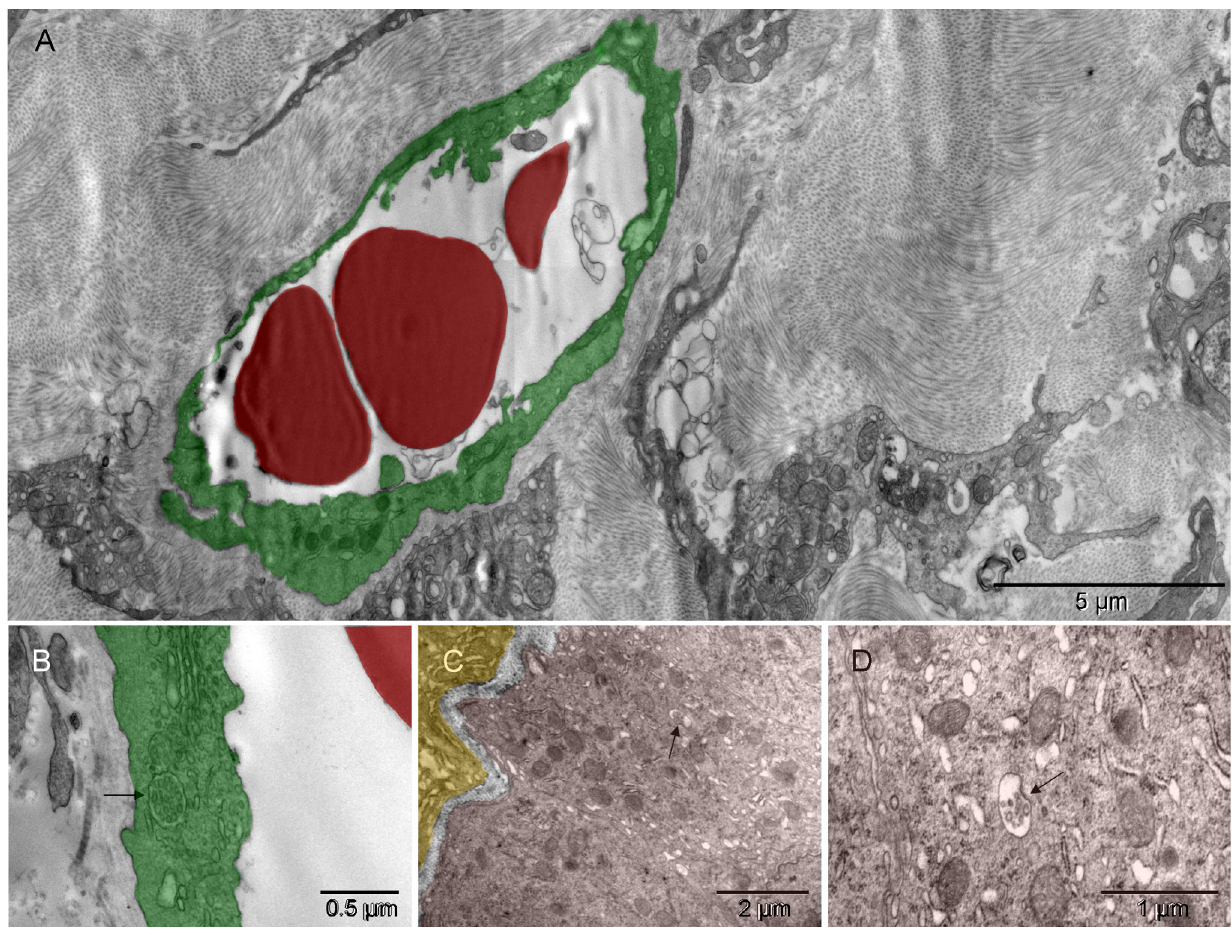
Figure S10. Role of collagen in morphogenesis of primitive vessels. The primitive vessels were embedded in copious amounts of collagen [ A ]. The wall of such vessels (green) typically was polarized; it had caveolae on the luminal surface and collagen abluminally [ B ]. Collagen-making cell (yellow) and tumor edges (brown), accommodating each other’s curvatures, revealed interaction between the two [ C ]. The tumor seemed to benefit from collagen support provided by the nonmalignant neighbor as well as appearing to have acquired the ability to synthesize some by itself. Arrows in [ B , C & D ] point towards intracellular bundles of collagen fibers; [ D ] is the enlarged collagen- containing region of [ C ]. Dilated cisternae of endoplasmic reticulum depleted of ribosomes to a variable degree resembled vesiculo-vacuolar organelles (VVOs) 59 [ D